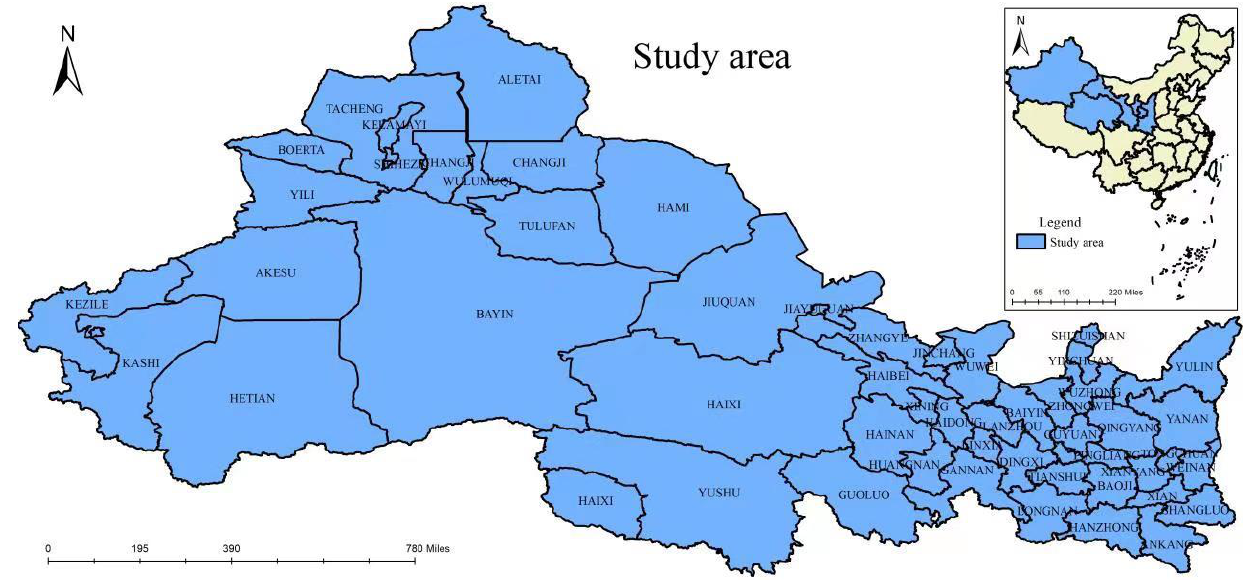
Figure 1. Study area.